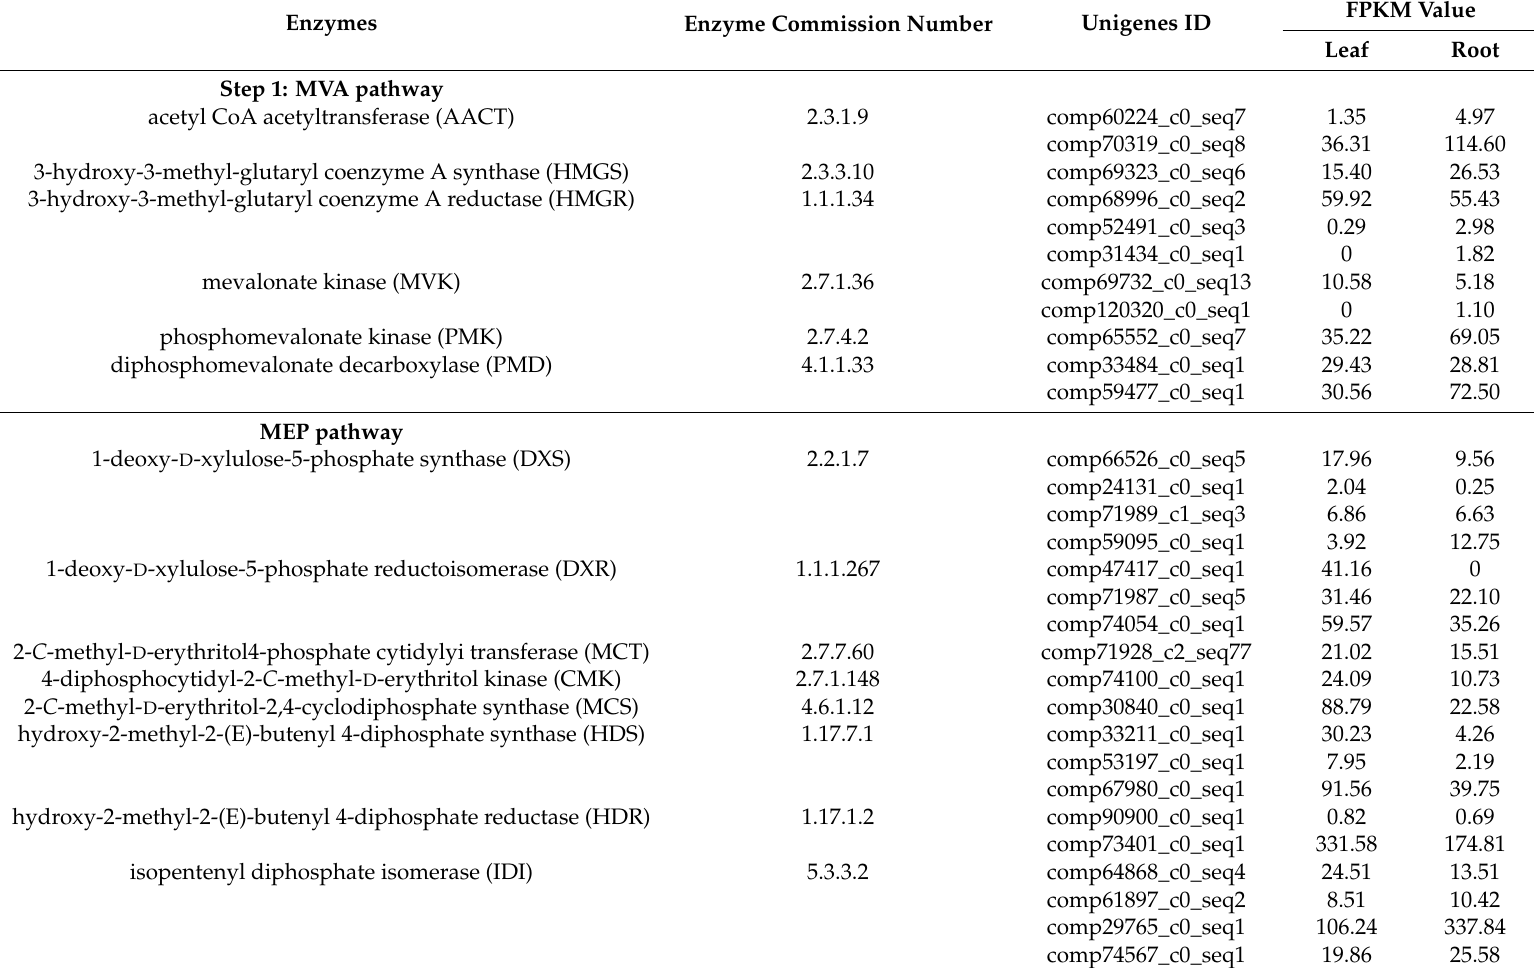
Table 3. The FPKM value of unigenes which encode enzymes involved in 20E